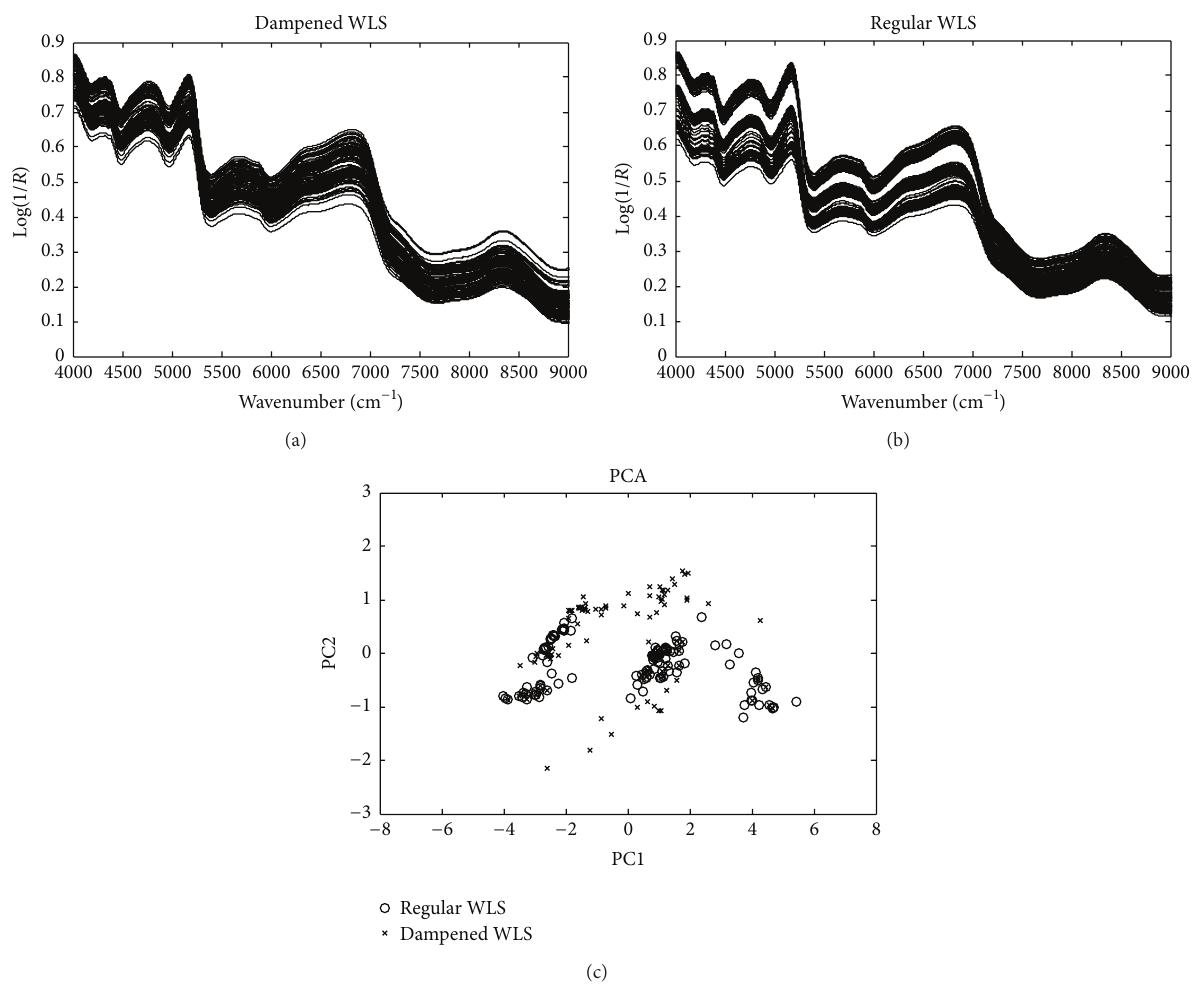
Figure 1: The raw NIR spectra and principal component analysis of 167 regular and 118 dampened WLS